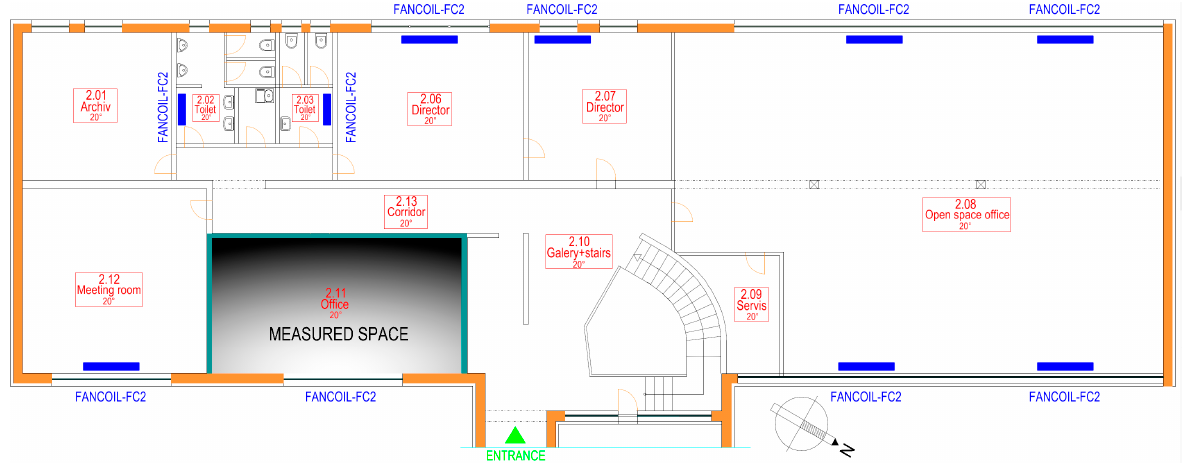
Figure 3. Floor plan of the 2nd floor.